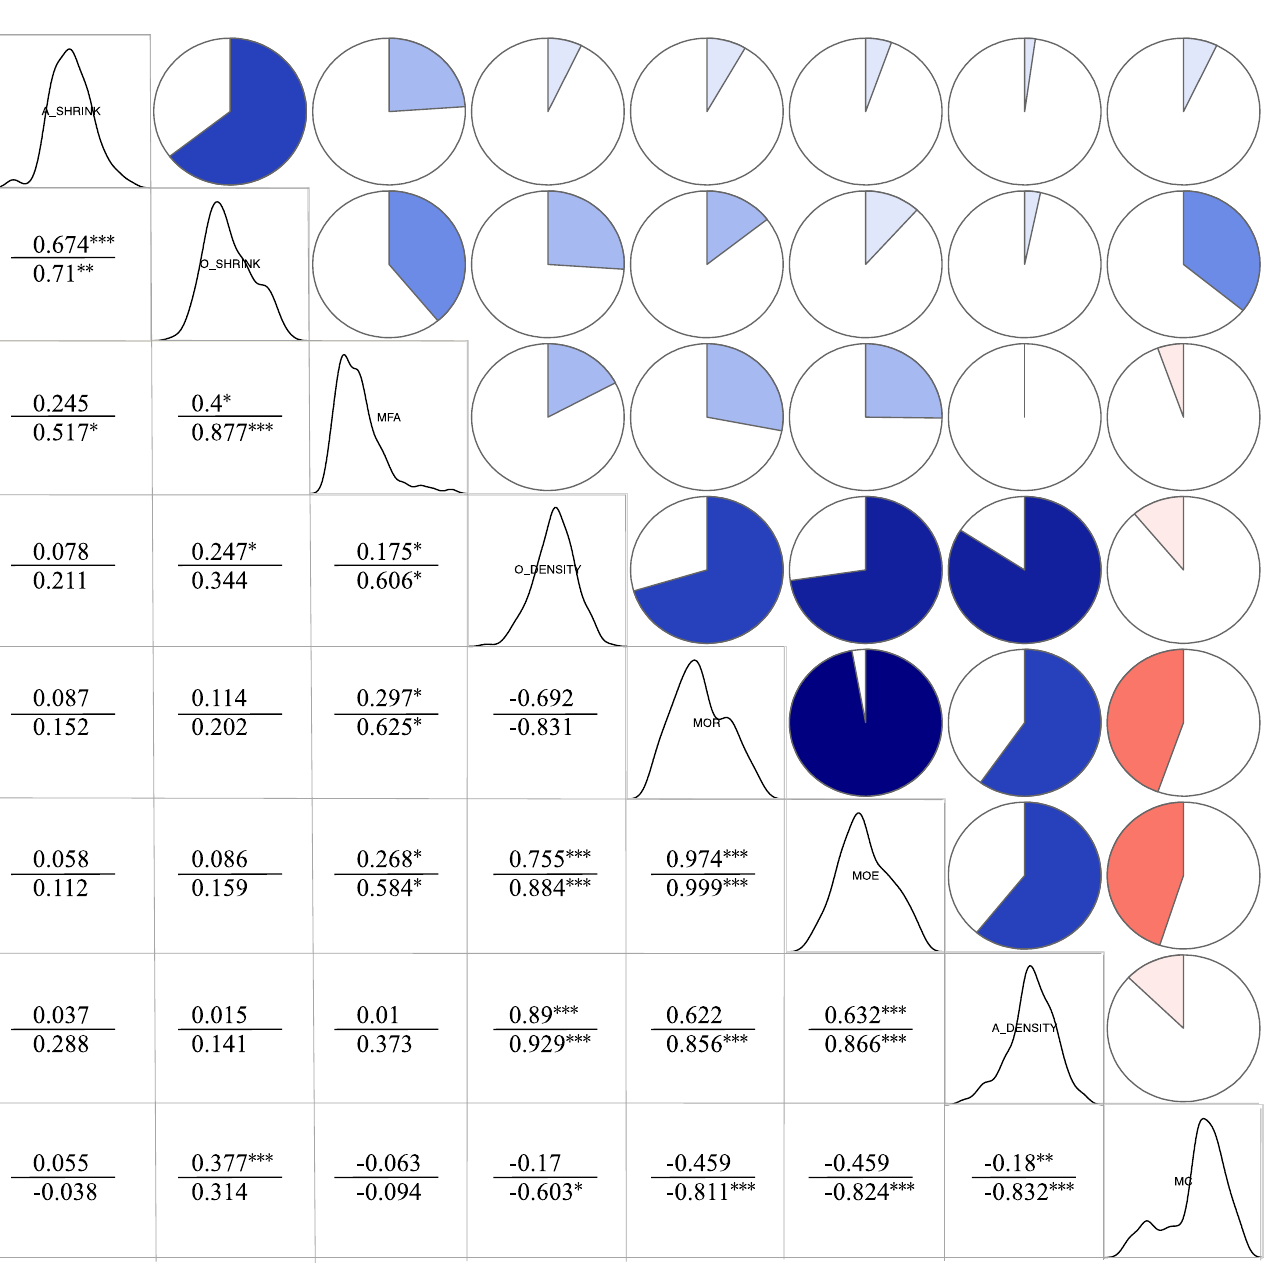
Figure 5. Correlation analysis of 8 material properties in Moso bamboo ( Phyllostachys edulis ). Notes: O_SHRINK: oven-dried volume shrinking ratio, A_SHRINK: air-dried volume shrinking ratio, MC: moisture content, O_DENSITY: oven-dried density, A_DENSITY: air-dried density, MFA: microfibril angle, MOR: bending strength, MOE: modulus of elasticity. The one above the diagonal line is the pie chart of the phenotypic correlation coefficient, the one below the diagonal line is the phenotypic correlation coefficient (up) and genetic correlation coefficient (down). *** stands for 0.1% level prominent, ** stands for 1% level prominent, * stands for 5% level prominent.